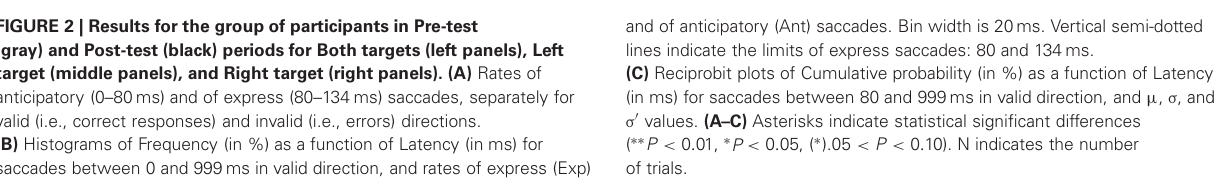
and of anticipatory (Ant) saccades. Bin width is 20ms. Vertical semi-dotted lines indicate the limits of express saccades: 80 and 134ms. (C) Reciprobit plots of Cumulative probability (in %) as a function of Latency (in ms) for saccades between 80 and 999ms in valid direction, and μ , σ , and σ (cid:4) values. (A–C) Asterisks indicate statistical significant differences ( ∗∗ P < 0 . 01, ∗ < 0 . 05, ( ).05 ∗ < P < 0 . 10). N indicates the number of